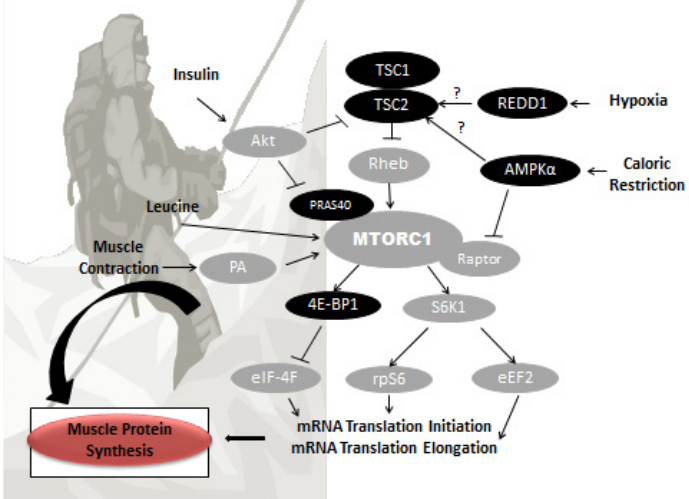
Figure 1. A simplified schematic diagram of the mammalian target of rapamycin complex 1 (mTORC1) signaling pathway and proposed cellular regulation of muscle protein synthesis in response to hypoxia, caloric restriction, insulin, muscle contraction, and leucine. Proteins labeled as gray are positive regulators of mTORC1 and/or muscle protein synthesis and proteins labeled black are negative regulators of mTORC1 and/or muscle protein synthesis. TSC1, tuberous sclerosis complex 1; TSC2, tuberous sclerosis complex 2; Rheb, Ras-homologue enriched in brain; REDD1, gene regulated in DNA damage responses and development; AMPK α , AMP-activated protein kinase alpha; PRAS40, proline-rich Akt substrate 40; Raptor, regulatory associated protein of mTOR; S6K1, p70 ribosomal S6 kinase 1; rpS6, ribosomal protein S6; eEF2, eukaryotic elongation factor 2; 4E-BP1, 4E binding protein 1; eIF-4F, eukaryotic initiation factor 4F; PA, phosphatidic acid; Akt, protein kinase